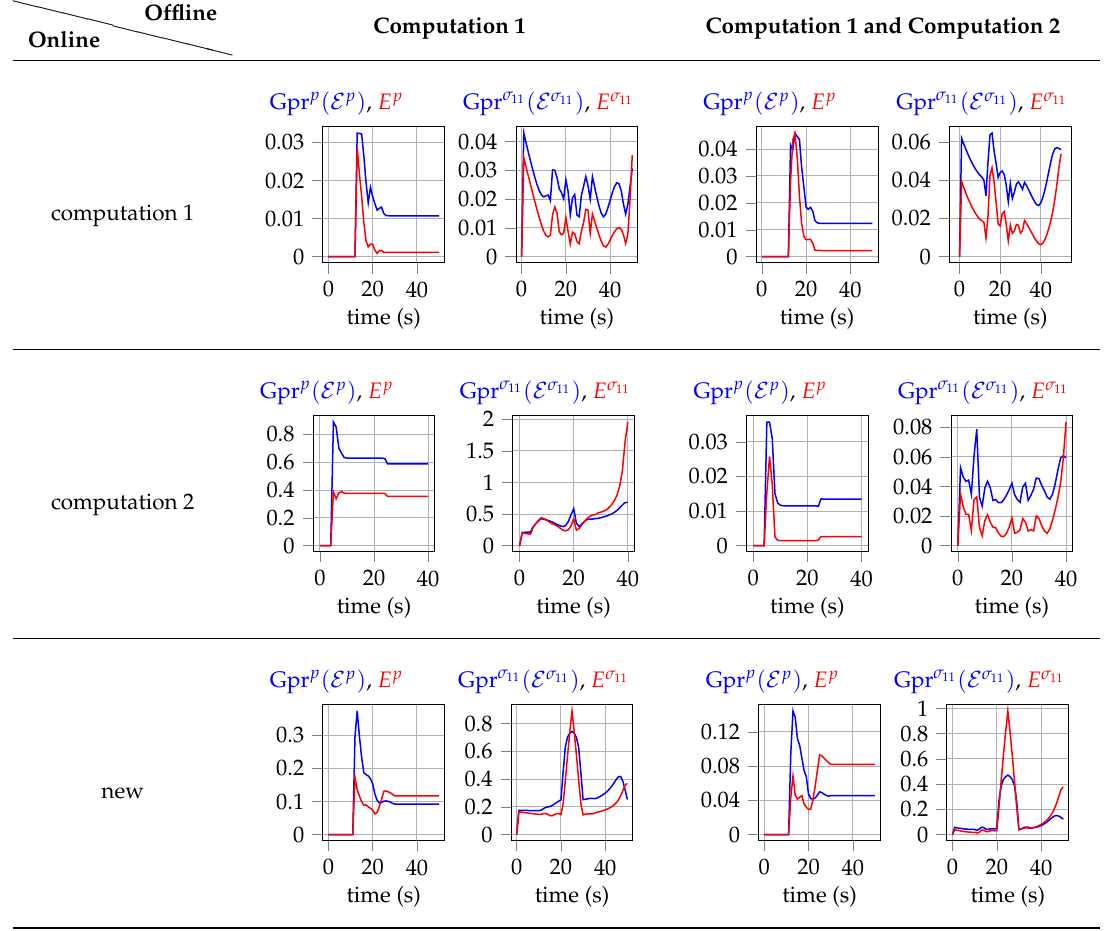
Table 3. Comparison of the error indicator (19) with the error (12) for various offline and online variabilities, without enrichment of the reduced order model. The category “offline” for the columns refers to the variabilities used in the data generation step of the offline stage, whereas the category “online” for the rows refers to the variability considered in the online stage.